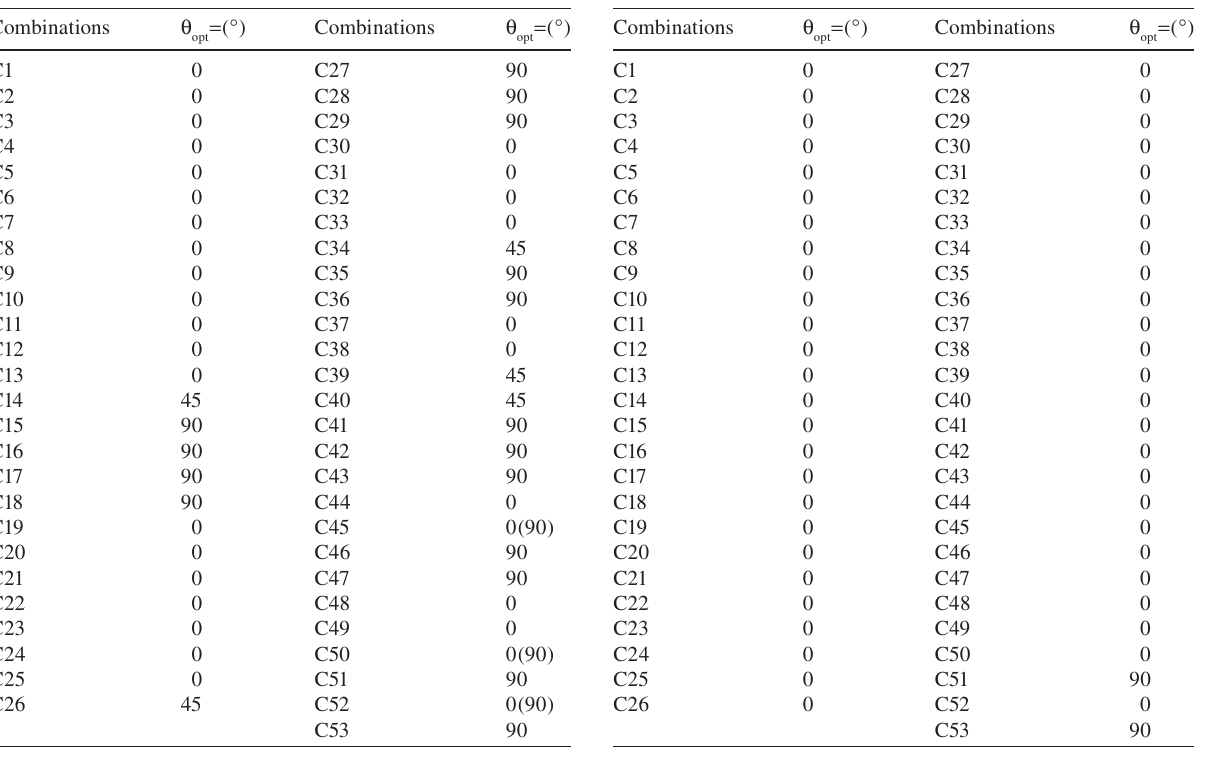
Table 9 Optimum fi ber orientations for laminated plates with intermediate line supports for ( CSCS ) boundary condition.